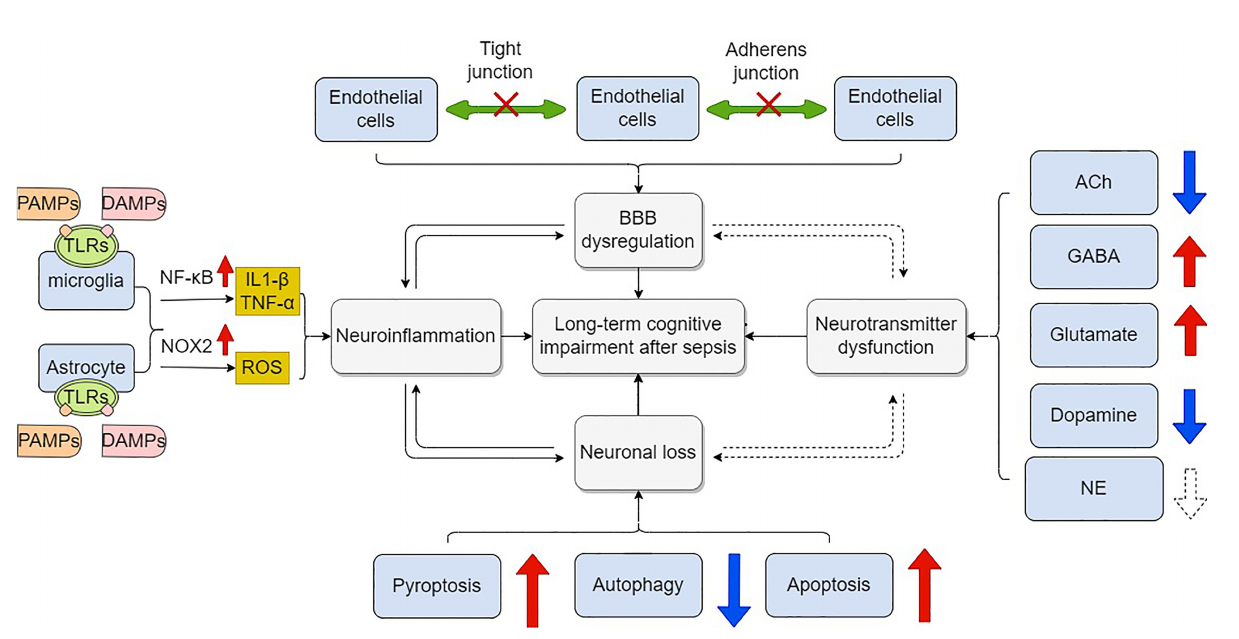
FIGURE 3 | Mechanisms of long – term cognitive impairment after sepsis. Blood brain barrier is composed of endothelial cells, astrocytes and pericytes. These cells are connected by tight junctions, adherens junctions and gap junctions. Dysfunction of these components leads to increased permeability of BBB in response to sepsis, which facilitates long-term cognitive impairment. Microglia and astrocyte are over-activated mainly through the activation of NF- k B signaling when PAMPs and DAMPs including LPS by binding to their ligands (namely, TLRs) on cell membrane. Pro-in fl ammatory cytokines are subsequently over-produced while anti- in fl ammatory cytokines are down-regulated. Neuroin fl ammation further leads to cognitive impairment. Overproduction of ROS is medicated by NOX2 in activated microglia and astrocytes. Neuronal loss is common in sepsis. Apoptosis, autophagy, and pyroptosis are involved in the modulation of neuronal death. Finally, dysregulation of neurotransmitters including ACh, GABA, glutamate, dopamine and NE also contributes to cognitive impairment in sepsis. BBB, blood brain barrier; PAMPs, pathogen-associated molecular patterns; DAMPs, damage-associated molecular patterns; LPS, lipopolysaccharide; TLRs, toll like receptors; ROS, reactive oxidative species; NOX2, NADPH oxidase 2; ACh, acetylcholine; GABA, Gamma-aminobutyric acid; NE,